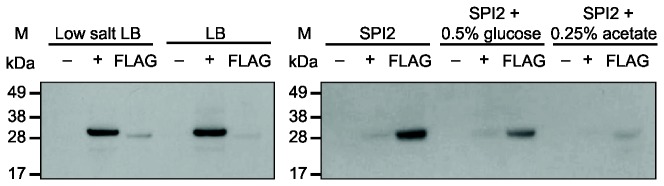
SDS-PAGE and western blot analysis of epitope-tagged YehT protein from S.
Typhi BRD948. Proteins from whole cell bacterial lysates were transferred after electrophoretic separation in a 12% SDS-PAGE gel (Invitrogen) onto a nitrocelluose membrane (Invitrogen) and probed with anti-FLAG M2 monoclonal antibodies (Sigma). Lanes: (M) protein molecular weight markers (SeeBlue Plus2 Pre-stained standard; Invitrogen); (-) proteins extracted from S. Typhi BRD948 (negative control); (+) proteins extracted from S. Typhimurium SL1344 ΔfliA (positive control, 27.4kDa); FLAG proteins extracted from S. Typhi ΔyehT-tagged (27.4kDa). Bacteria was grown in low salt LB; normal salt LB; SPI-2 inducing; SPI-2 + 0.5% glucose; SPI-2 + 0.25% acetate overnight, shaking at 37°C.